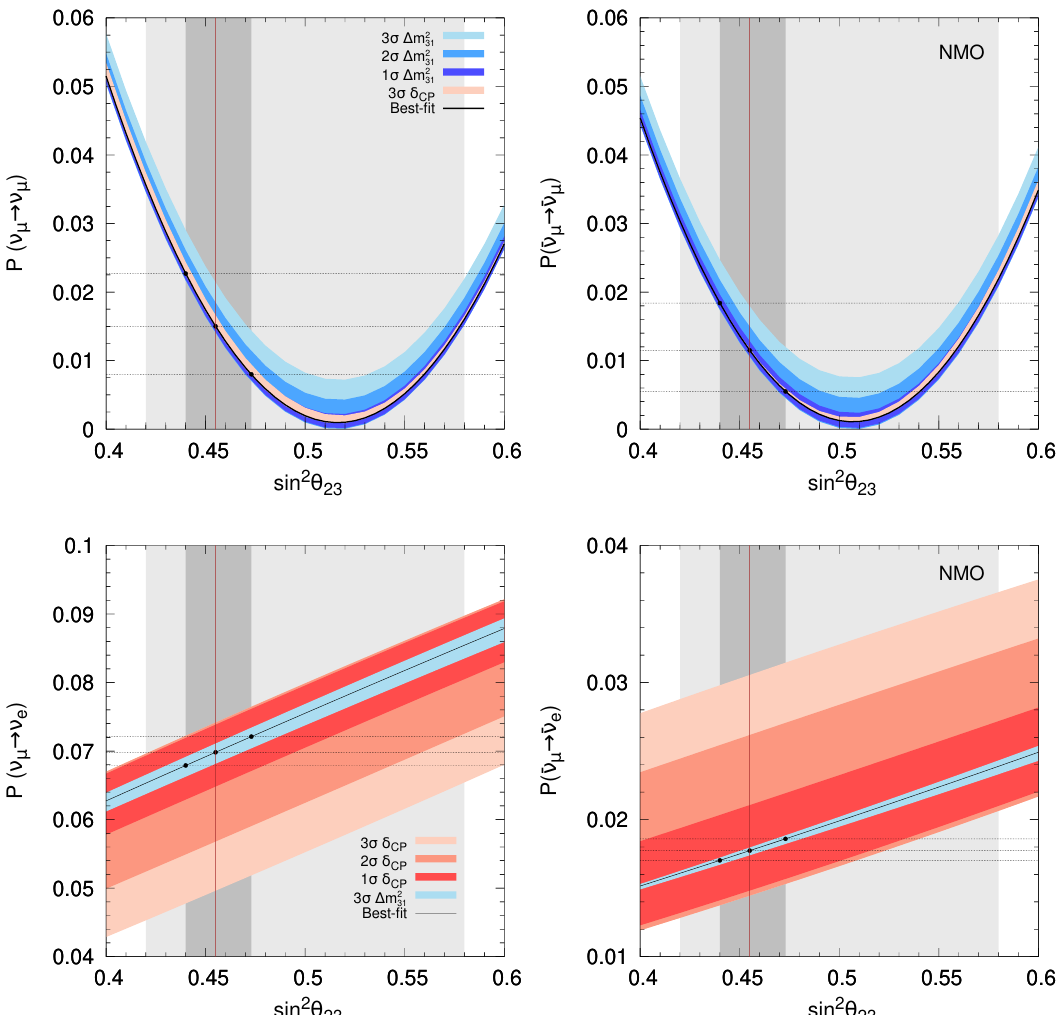
Figure 2 . Probability as a function of sin 2 θ 23 for E = 2 . 5 GeV, L = 1284 . 9 km, and ρ = 2 . 848 g / cm 3 assuming NMO. The top (bottom) panels are for disappearance (appearance) channel. The left (right) panels are for neutrino (antineutrino). The black solid curves show the probability considering the best-fit values of oscillation parameters as given in table 1. The three shaded blue (red) regions depict the variations in probability due to the present 1 σ, 2 σ, and 3 σ allowed ranges in ∆ m 2 The dark (light)-shaded grey area shows the currently allowed 1 σ (2 σ ) region in sin 2 θ best-fit value of sin 2 θ = 0 . 455 as shown by the vertical brown line. See table 1 for details. Note 23 that y-ranges are different in the bottom two